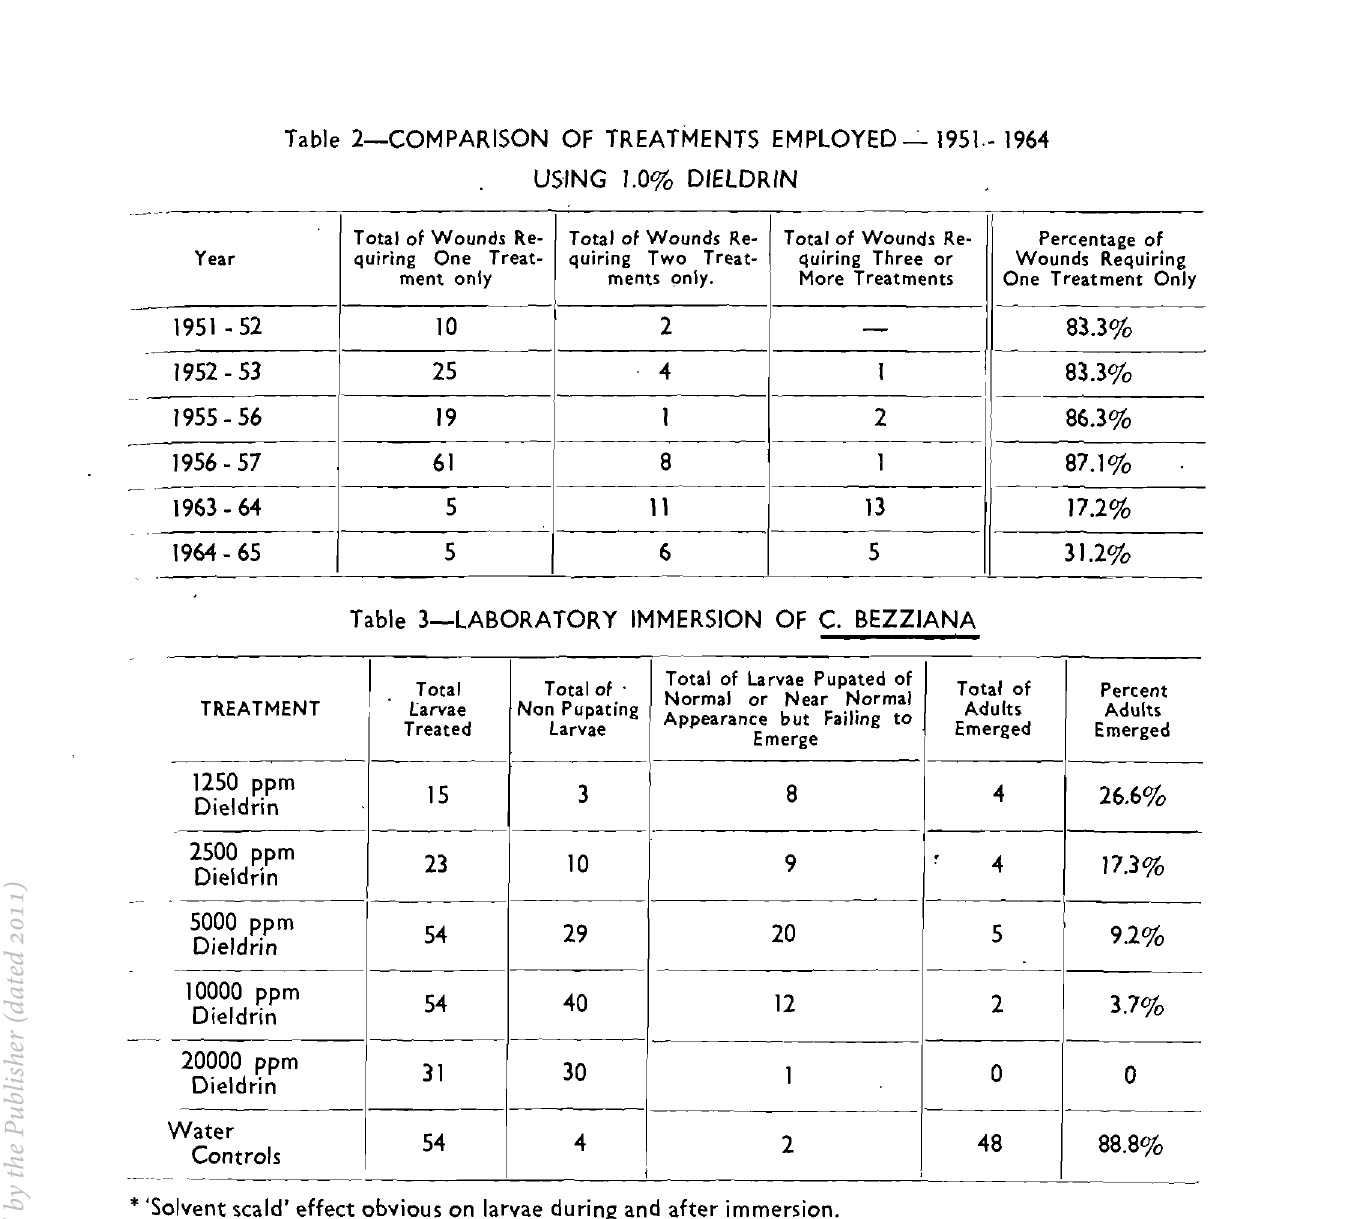
Table 3-LABORATORY IMMERSION OF C.